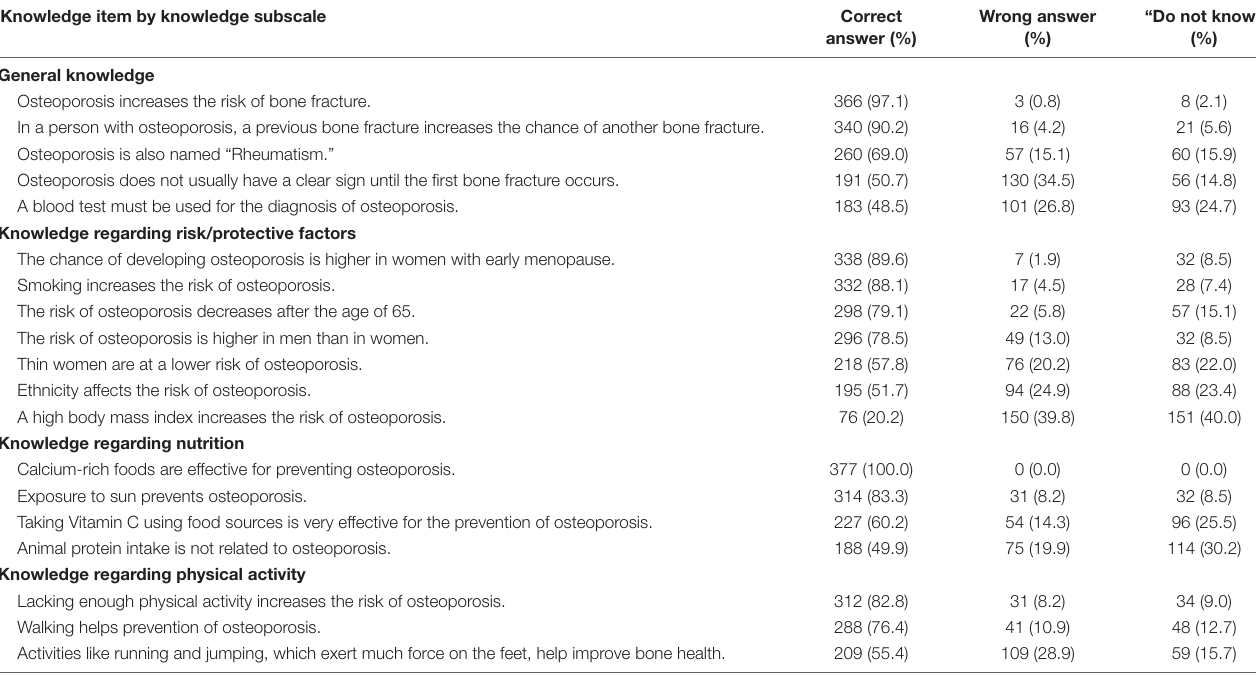
TABLE 3 | Knowledge items and responses of the teachers to